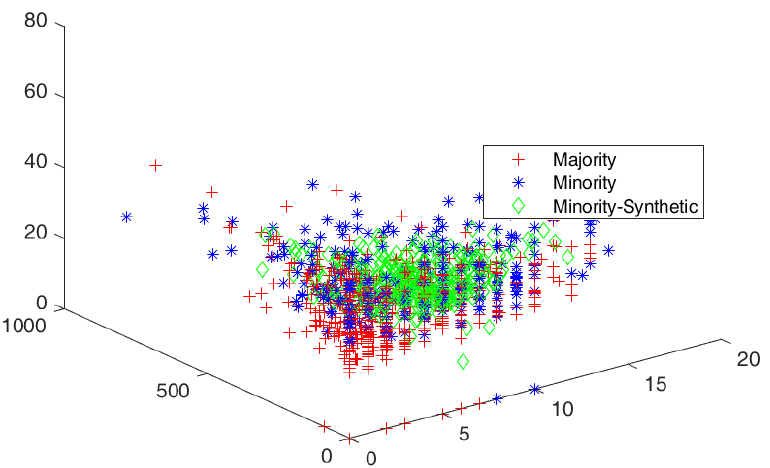
Figure 3. Cluster view of data distribution in cluster among majority and minority for the proposed SMOTE-PSOEV for Pima dataset.